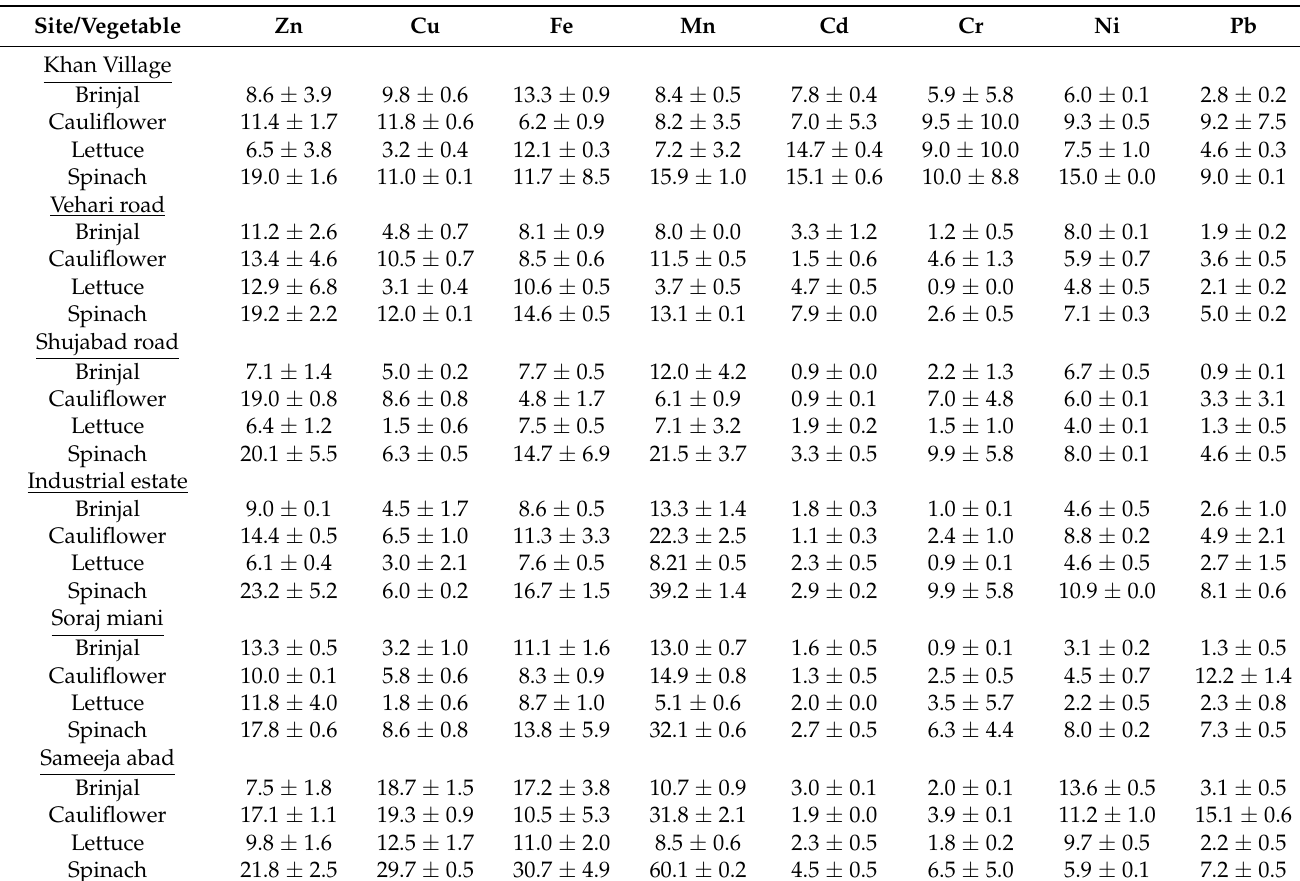
Figure 4. Relationships between the transfer factors (TF) of the vegetables (brinjal, cauliflower, lettuce, and spinach) and heavy metal (Ni and Pb) concentrations (mg kg − 1 dry weight) in the respective soils of the Khan Village, Vehari road, Shujabad road, Industrial estate, Soraj miani, and Sameej abad study sites. A relationship is significant at p < 0.05. Only significant relationships are retained to sustain the brevity of the manuscript. Table 2. Mean ( ± SD) values (unitless) of the soil–plant transfer factors (vegetable leaf concentration/soil concentration) for all heavy metals across the study sites